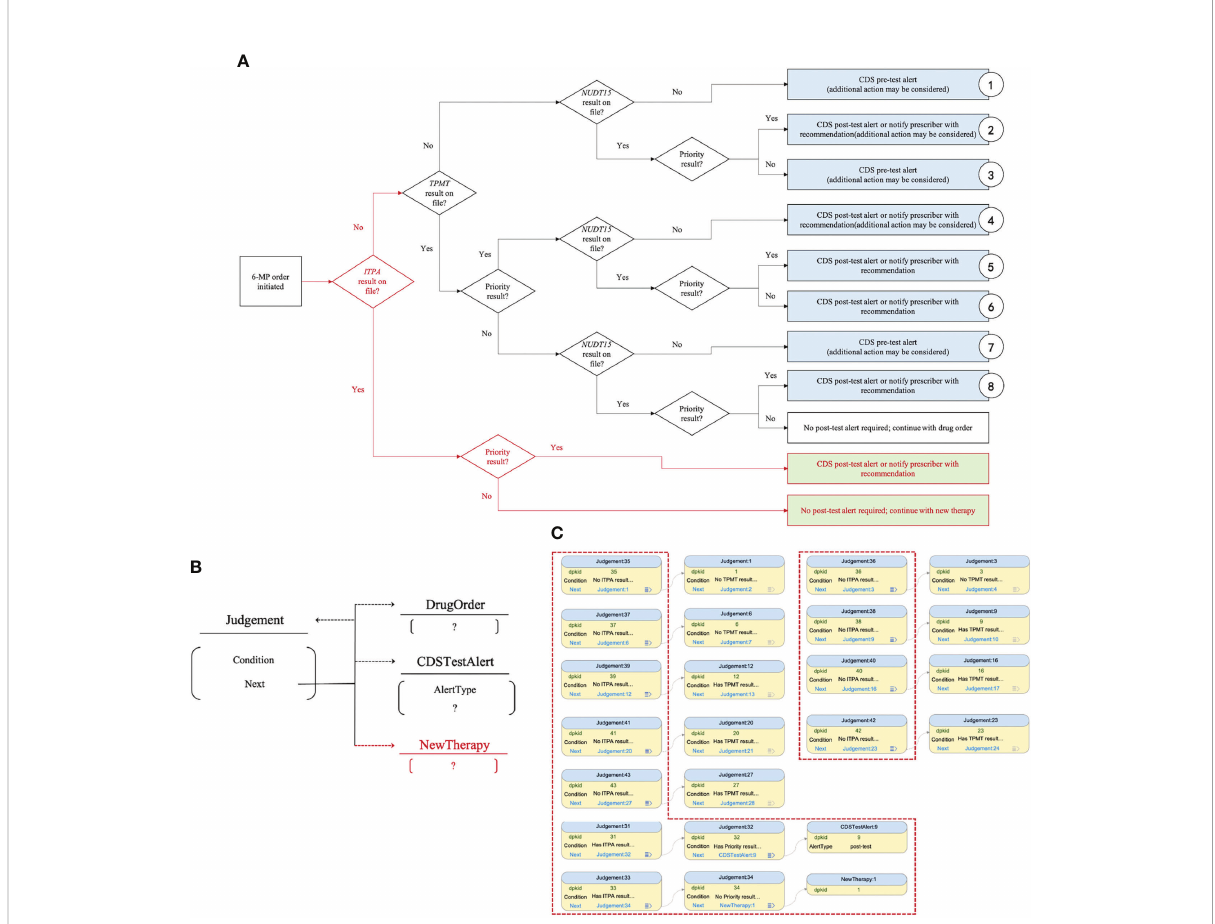
FIGURE 4 Change of decision fl ow modelled by MMKP. (A) Addition of a new genotype test result ITPA and its new therapy for patients. (B) Knowledge content re fl ecting the new decision fl ow in MMKP. (C) Knowledge content entry in MMKP, with the updated content in a red dashed